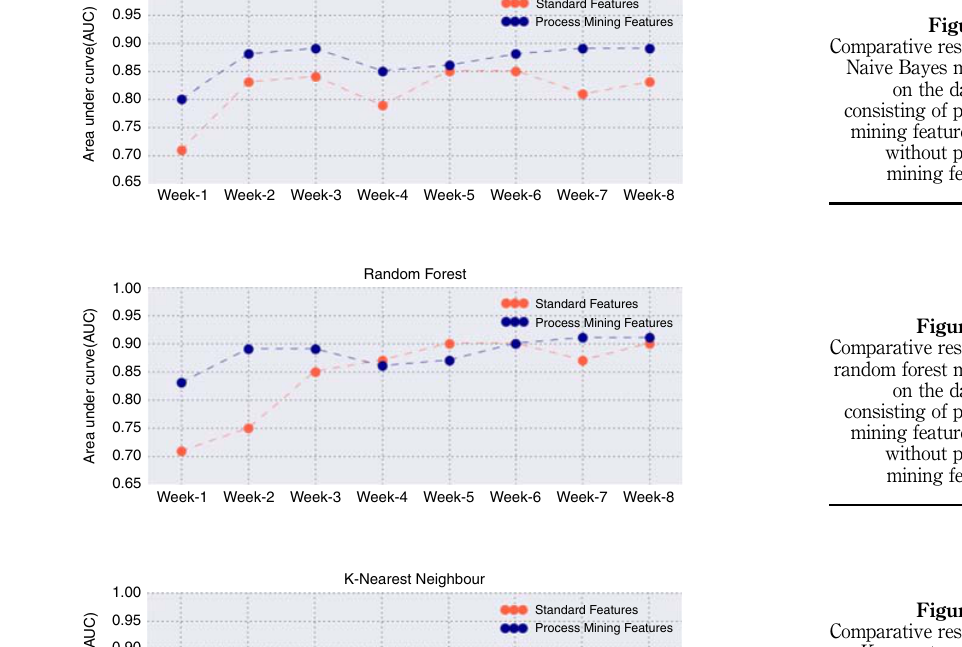
Figure 11. Comparative results of K -nearest neighbor method on the data set consisting of process mining features and without process mining